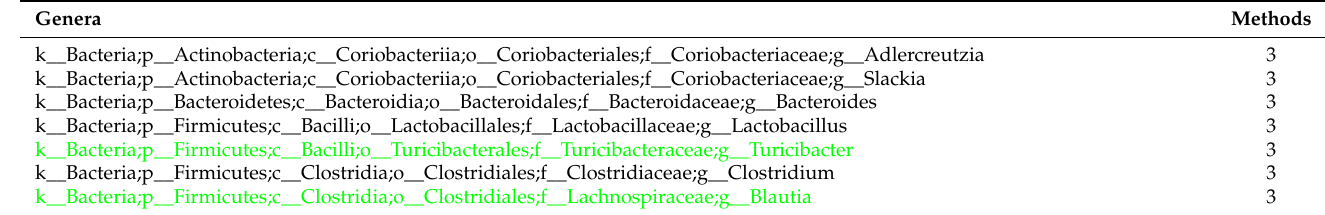
Table 3. List of the key genera differentiating between healthy and diseased microbiomes. The genera were selected by intersecting the relevant genera list coming from DA, RF, and sPLS-DA analyses. Only the genera that were present in more than two out of three of these lists were included in this table, where the last column shows the number of methods that identified them as relevant (see Materials and Methods). Genera colored in green and orange are taxa respectively included in or related to the Dysbiosis Index (see Materials and Methods). Taxonomies ending with “s__” mean that there was a best match in Greengenes, but that the best match did not have an assignment at the species level. In contrast, a “__” is used to indicate that classification did not arrive down to the species level because a close match did not exist in the reference database or because multiple equivalent matches were